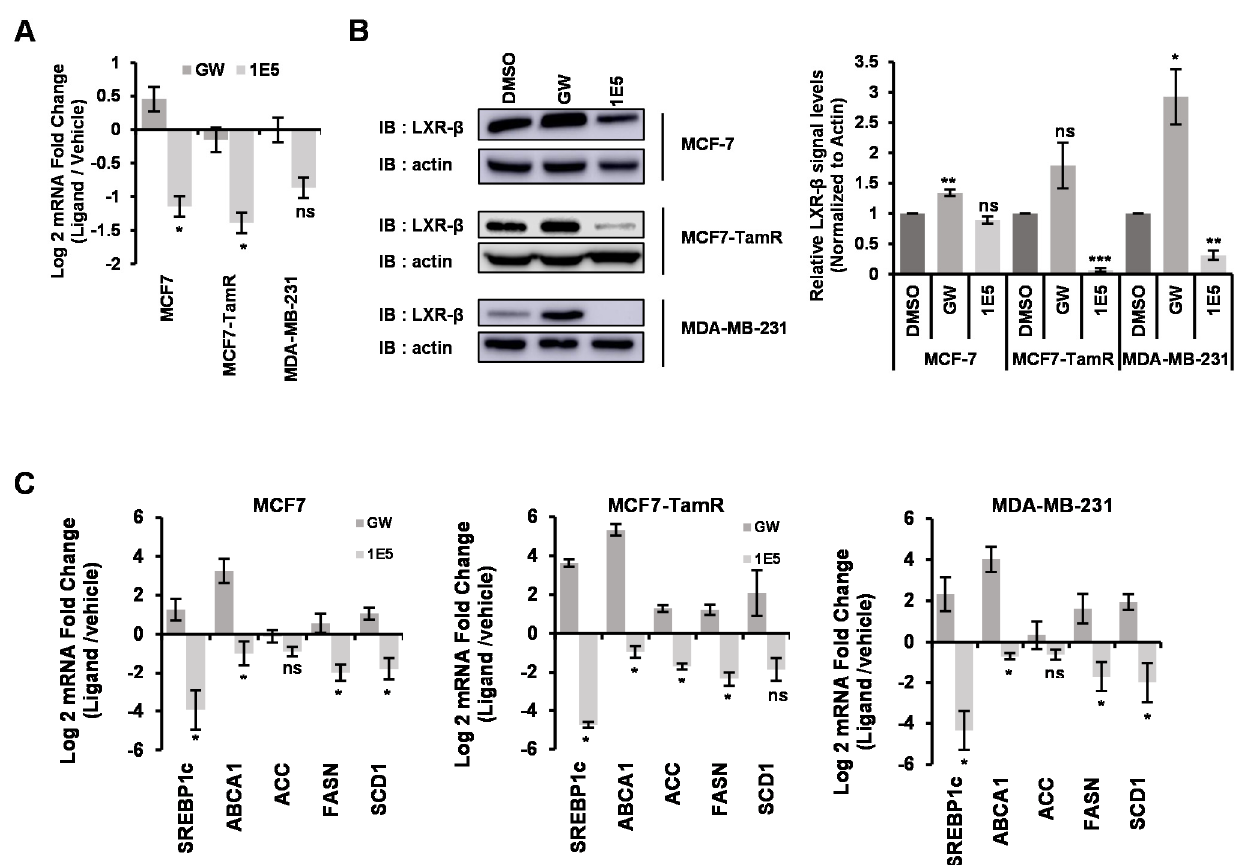
Figure 3. 1E5 disrupts LXR β transcription and translation and acts as an inverse agonist. ( A ) LXR β transcript levels were reduced in breast cancer cell lines upon 48 h of 1E5 (10 μ M) treatments. ( B